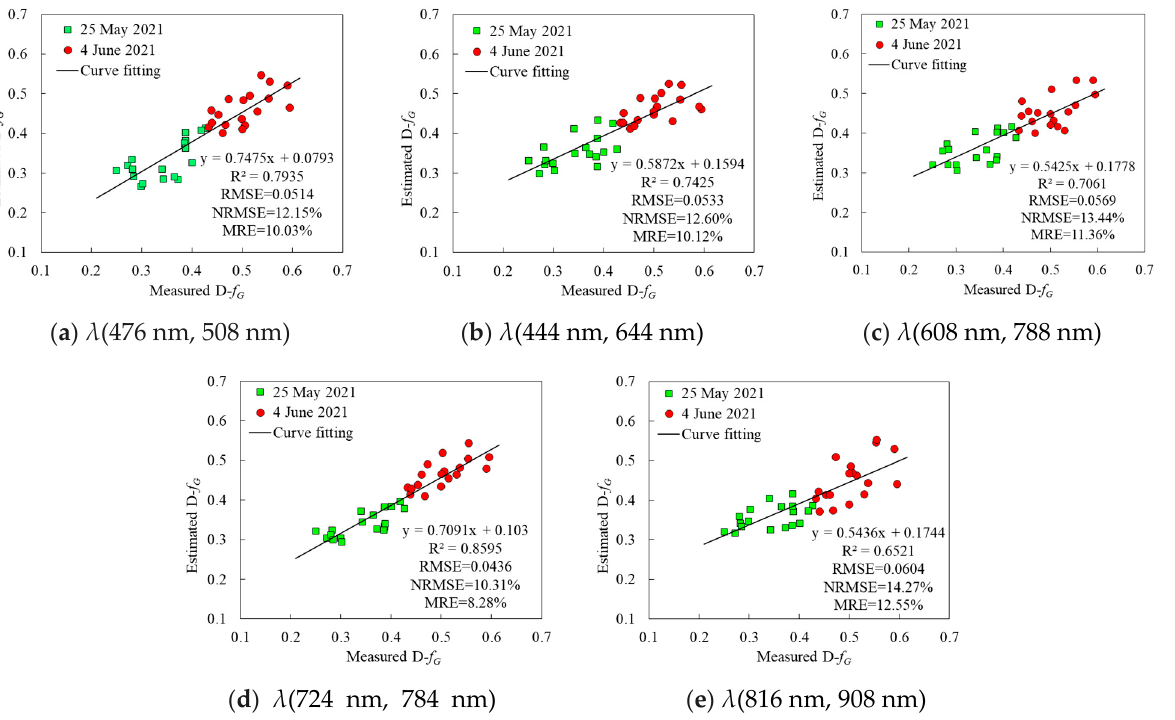
Figure 6. Verification of the D- f G estimates based on the sensitive UAV hyperspectral band centers. As shown in Table 2, when the NDSI values constructed by the centers of the five pairs of selected sensitive hyperspectral bands were fitted with the D- f G , all the relationships reached a very significant level ( p < 0.01), and the determination coefficient R 2 was between 0.6047 and 0.6843. The verification results showed that the statistical model established between the NDSI and the D- f G had good estimation effects, with the D- f G estimation showing a high level of precision. In the estimation accuracy results of the D- f G , the fit R 2 was between 0.6521 and 0.8595, RMSE was between 0.0436 and 0.0604, NRMSE was between 10.31% and 14.27%, and MRE was between 8.28% and 12.55%. Moreover, the NDSI (724 nm, 784 nm) had the highest accuracy in estimating the winter wheat D- f G , with an RMSE, NRMSE and MRE of 0.0436, 10.31%, and 8.28%, respectively. Due to space limitations, only the UAV hyperspectral NDSI result and estimated D- f G values with the highest estimation accuracy, which correspond to the sensitive band centers λ (724 nm, 784 nm), are shown in this paper. The NDSI values calculated for Plots I-VI in the grain filling period and maturity period are shown in Figures 7 and 8, and the D- f G remote sensing estimates in the grain filling period and maturity period are shown